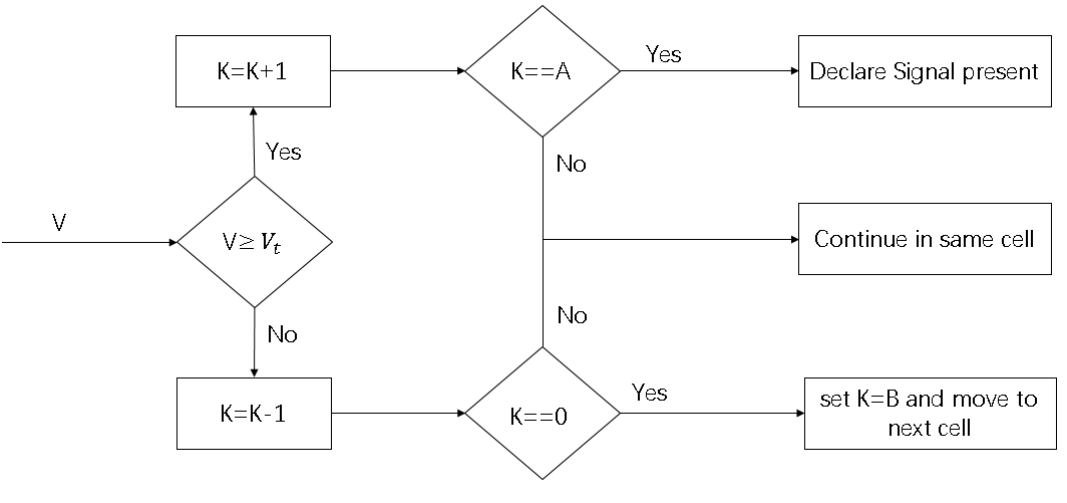
Figure 6. Tong search